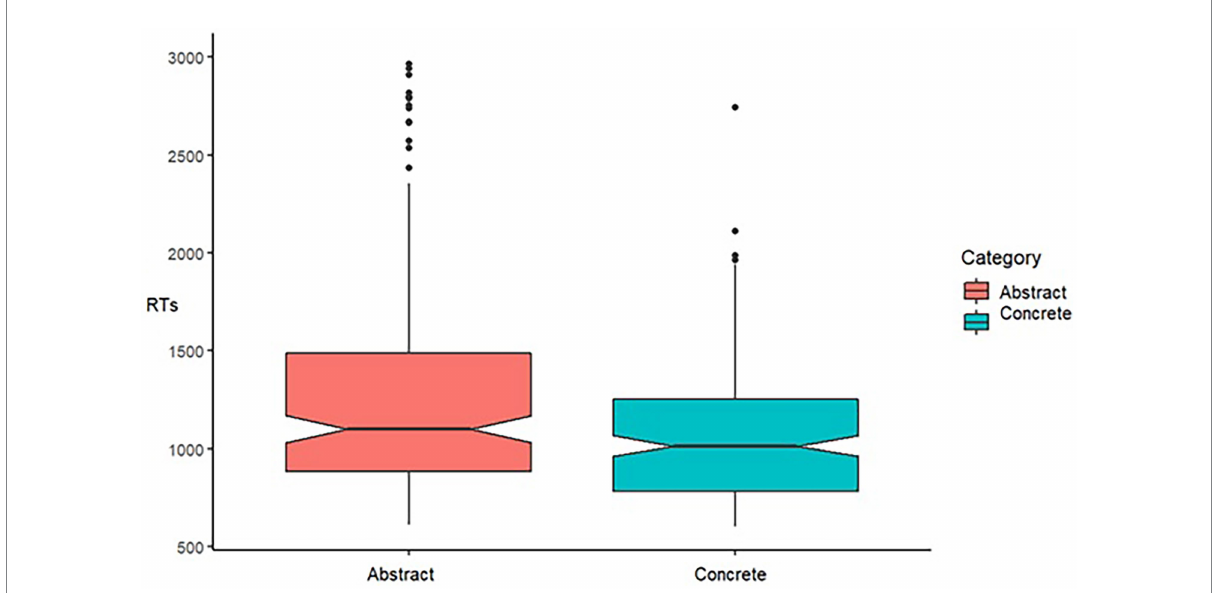
FIGURE 1 The analysis on RTs yielded a significant main effect of the Type of Concept (Abstract, Concrete), [ F (1, 523) = 10.28, p = 0.0014]. Concrete concepts are processed faster than Abstract concepts. Horizontal lines in the boxes indicate the median, upper and lower borders indicate I and III quartile, “whiskers” extend to the farthest points that are not outliers, dots represent outlier